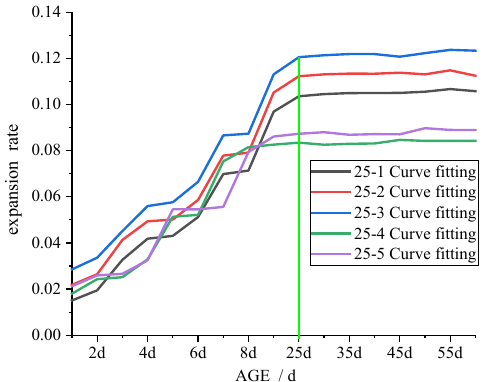
Figure 11. Curve of expansion rate and age of specimen with 25% binder.